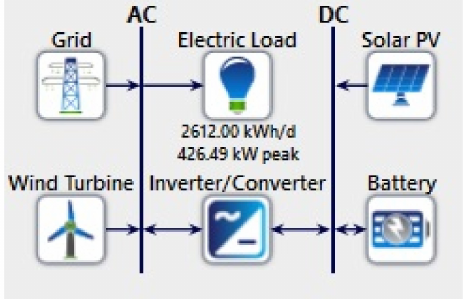
Figure 10. Schematic diagram of the on-grid hybrid